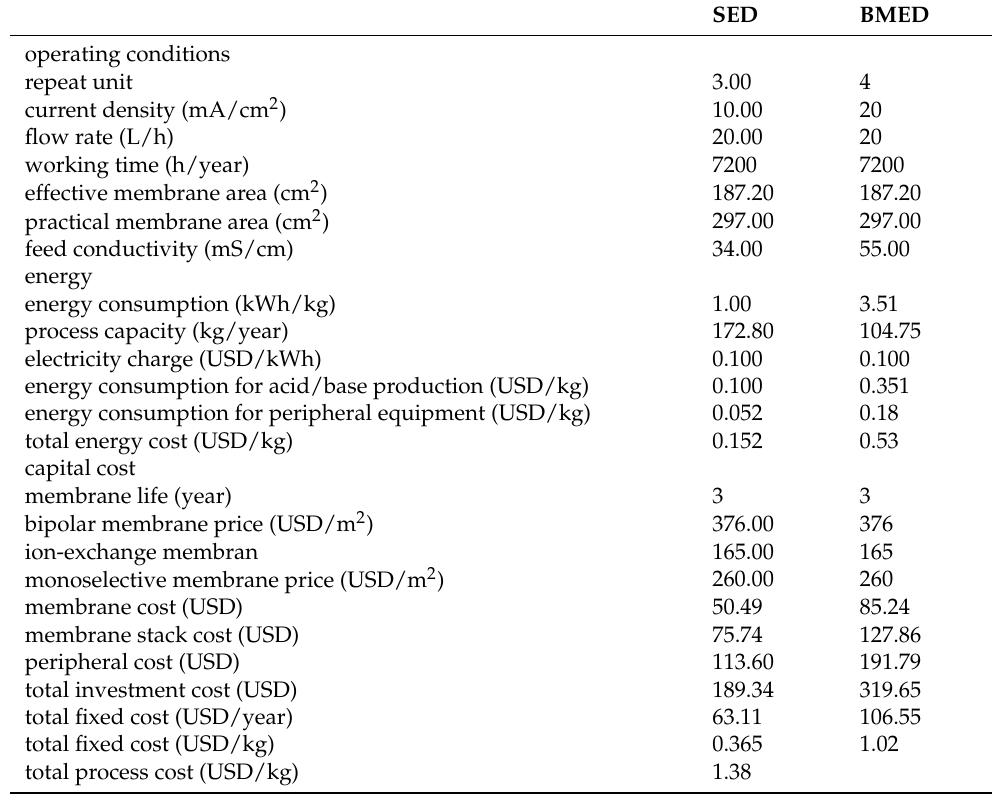
Table 8. The estimation procedure of BMED and SED process